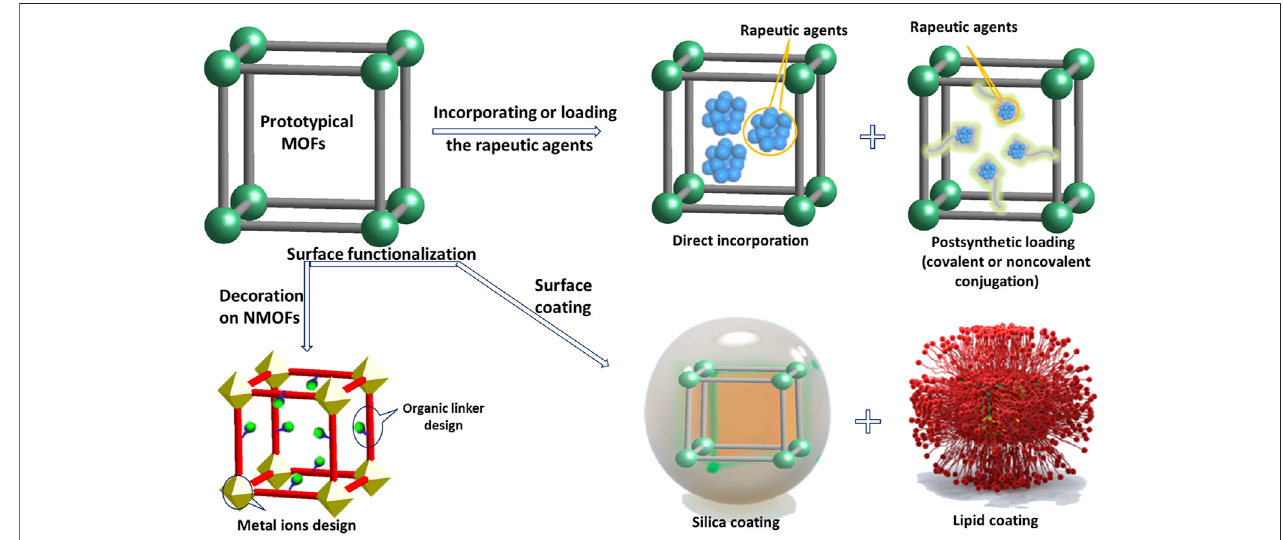
FIGURE 2 | Approaches described in this article for constructing NMOFs-based